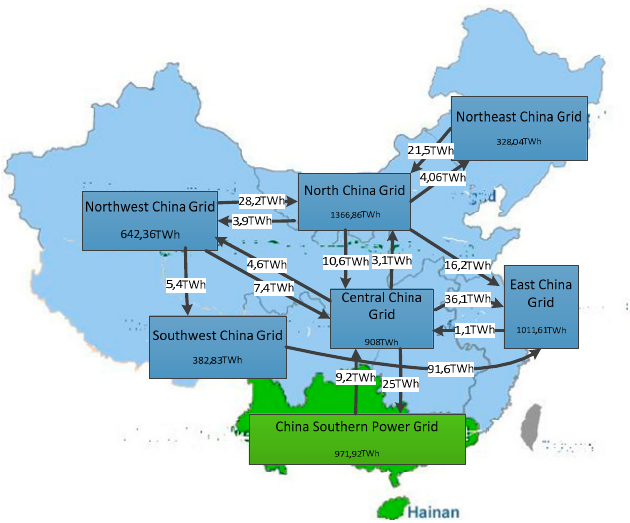
Figure 3. The transmitted electricity between regional grids in 2014. Source: Reproduced with permission from [6].